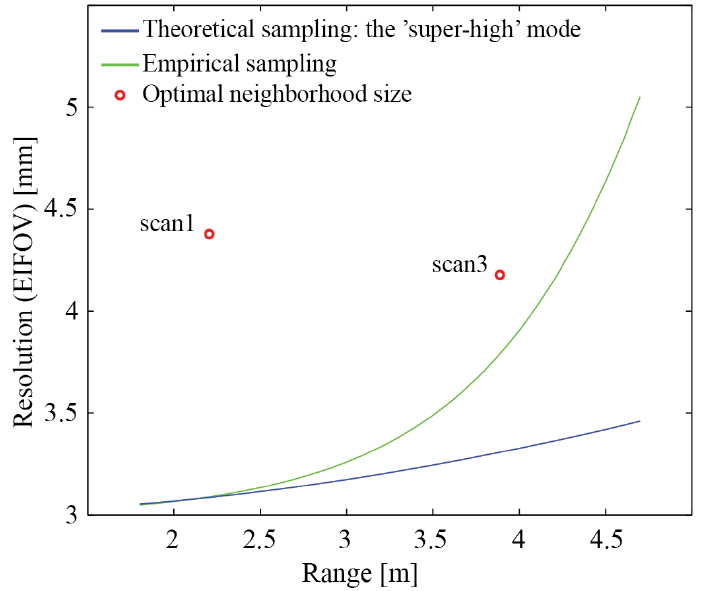
Figure 14. The effective instantaneous field of view (EIFOV) of an individual scan collect by Z + F IMAGER ® 5006i over the ranges observed within the analyzed